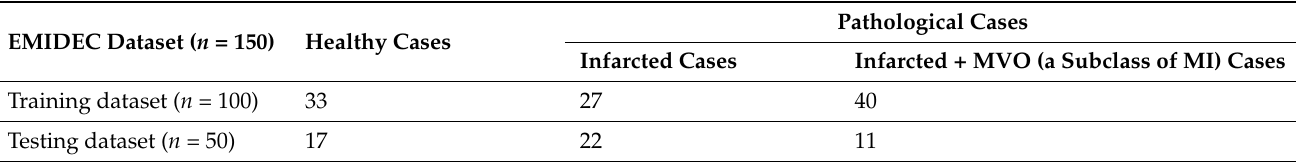
Table 1. Stratification of the EMIDEC